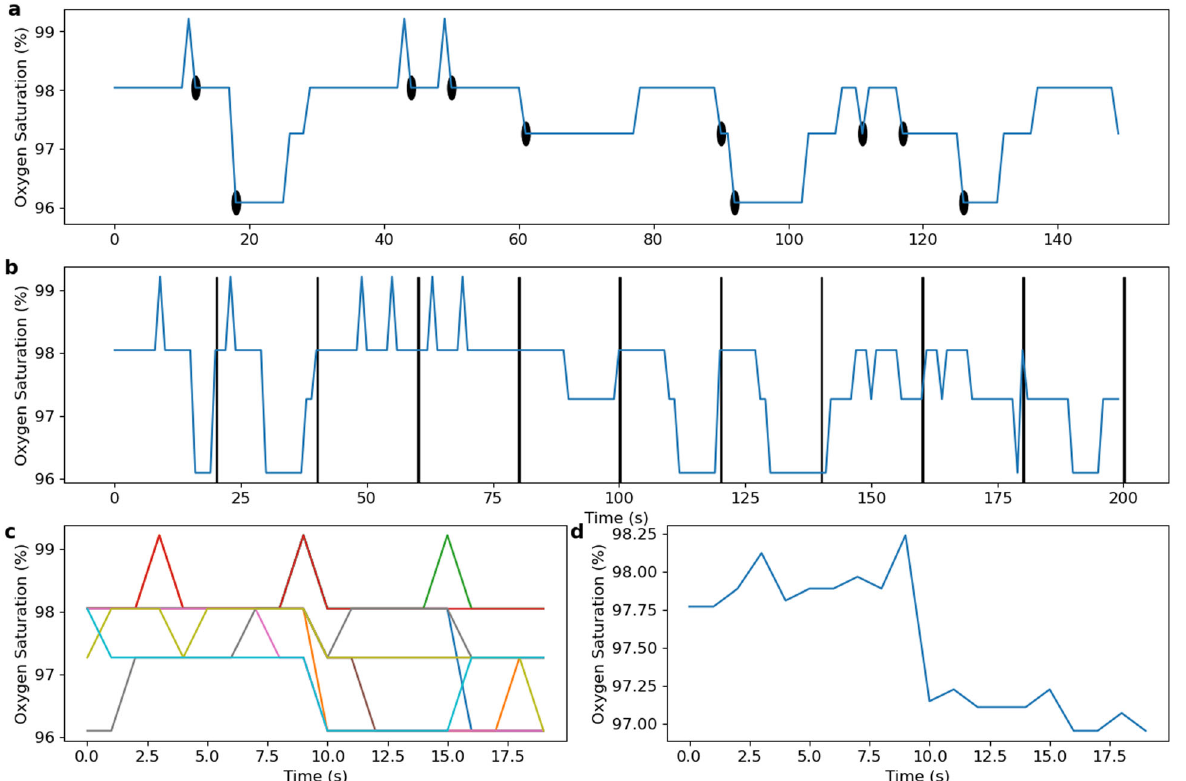
Fig. 5 PRSA analysis of the oximetry time series. In a , the oximetry time series, with anchor points highlighted. In b , concatenation of PRSA windows, de fi ned around each anchor points. In c , PRSA windows of top of each other. In d , the average of all the PRSA